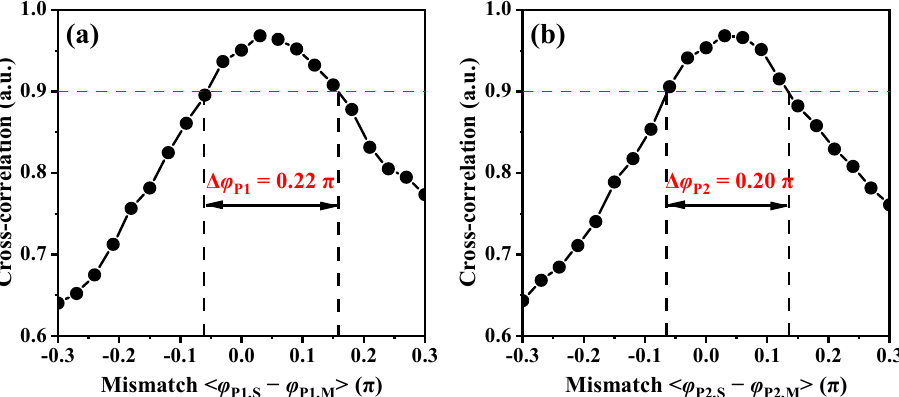
Figure 6. Influence of the phase shift of phase sections mismatch on chaotic synchronization coeffi- cients: ( a ) the phase shift of Phase 1 section ( φ P1 = 0) and ( b ) the phase shift of Phase 2 section ( φ P2 = π /2).